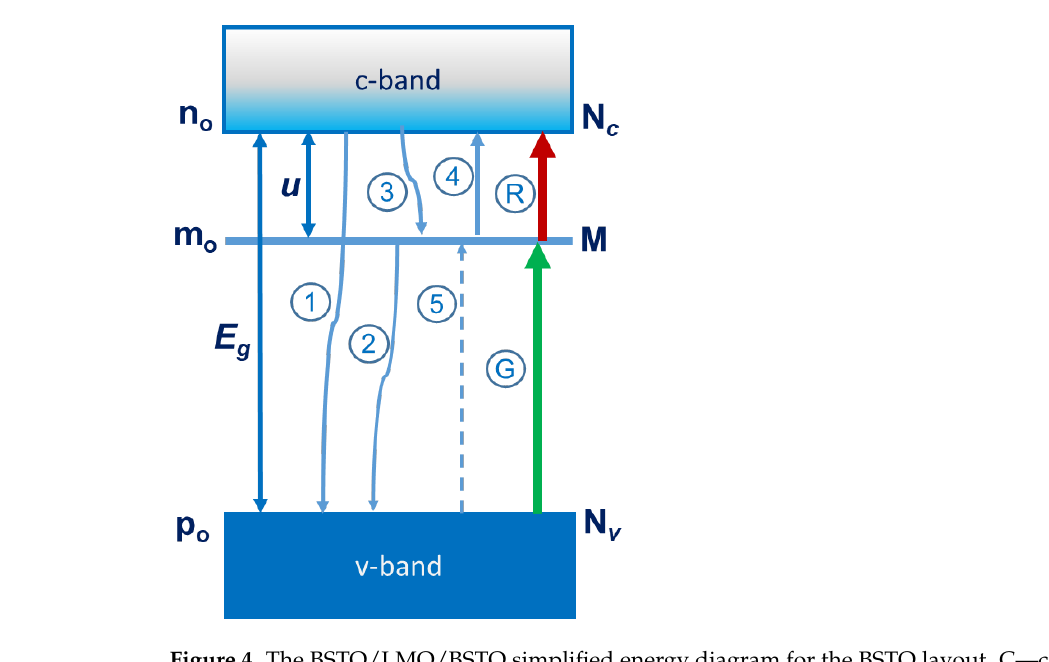
Figure 4. The BSTO/LMO/BSTO simplified energy diagram for the BSTO layout. C—conduction band, V—valence band, and M—trapping levels. Schematically shown are the processes of relaxation (1,2,3), green (G) and infrared (R) light irradiation, and thermal activation (4,5).